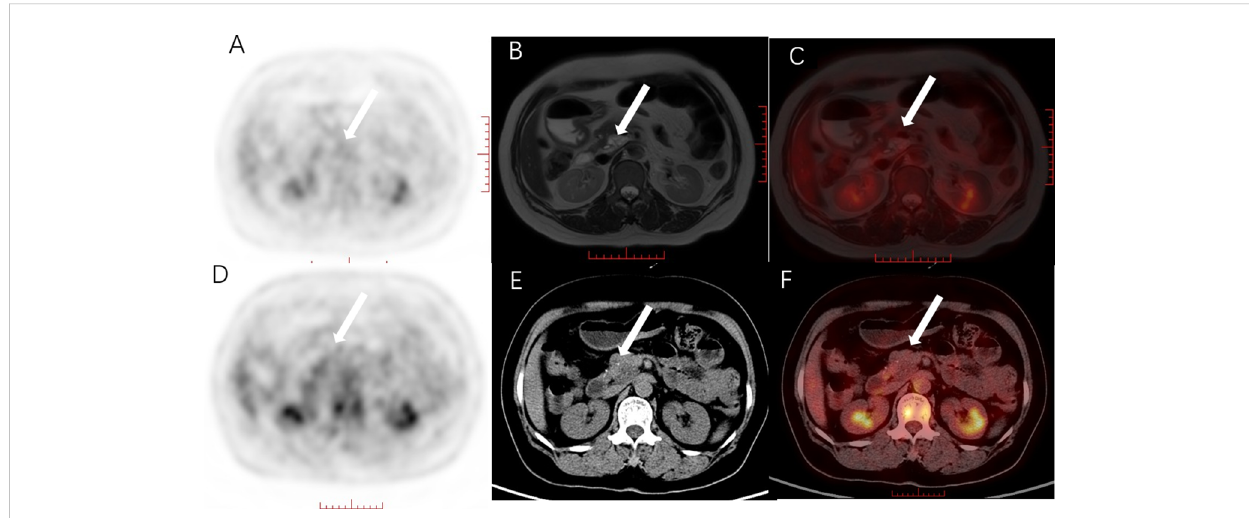
FIGURE 1 Female, 56 years old, with mucinous cystic tumor of the pancreatic head. (A) PET MIP image, no obvious hypermetabolism was found in the pancreas; (B) MRI T2WI, T2WI showed heterogeneous and slightly hyperintensive cystic-solid lesions; (C) PET/MRI fusion image, there was no metabolism on the fusion image, but A clear display of the cystic and solid components of the lesion is helpful for accurate diagnosis. (D) PET MIP image, suspected hypermetabolic foci in the pancreatic head area; (E) plain CT scan, the pancreatic head lesion was unevenly low-density, and dot- like high-density can be seen in it; (F) PET/CT fusion image, PET/CT fusion images showed no obvious metabolism compared with the pancreatic background. The white arrow shows the location of the lesion. PET/MRI fusion images clearly show the cystic and solid components of the lesions, which is helpful for accurate